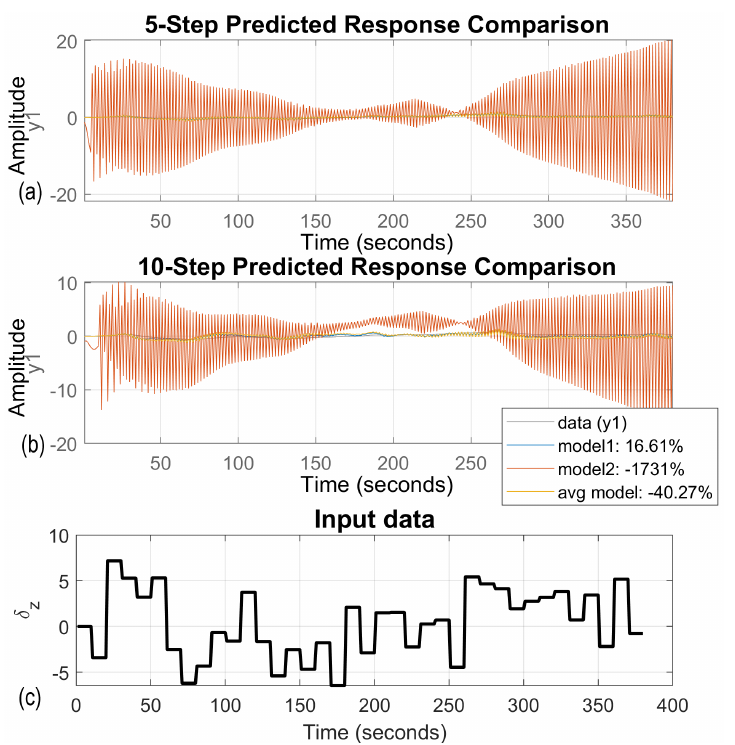
Figure 5. Examples of model predictions based on real-time lake validation data; ( a ) 5-steps ahead prediction, ( b ) 10-steps ahead prediction, ( c ) validation data sequence.